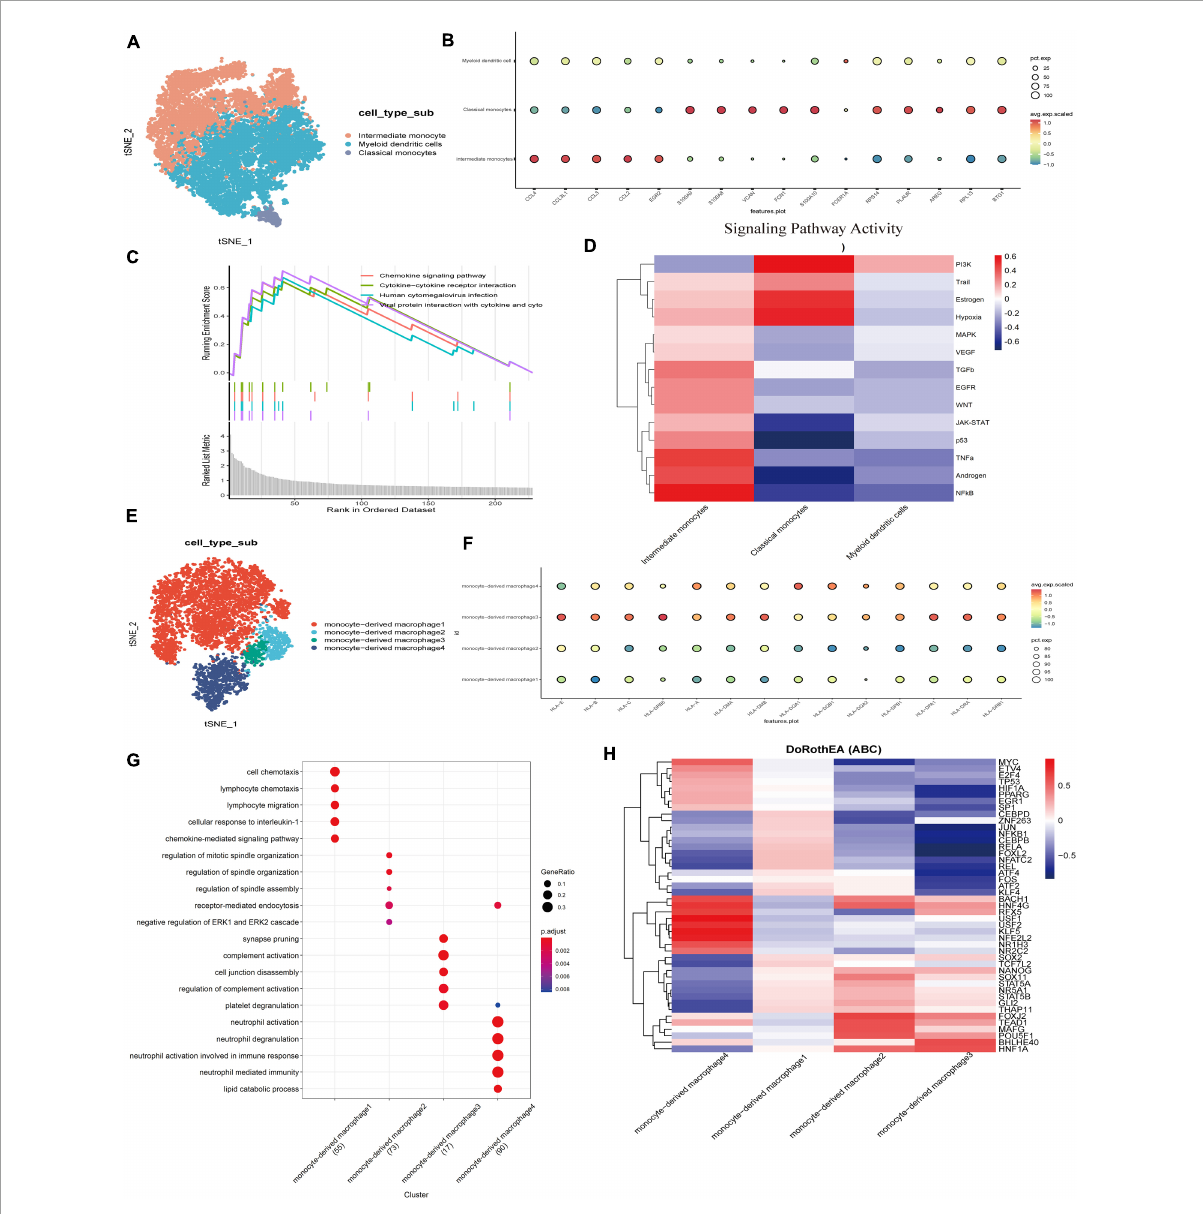
FIGURE3 Transcriptome analysis of myeloid cells led to the detection of predominantly monocytes and macrophages with pathways involved in immune metabolism and inflammation. (A) TSNE showing myeloid cell subsets. Different cell types are indicated by different colors. (B) Three major cell types in myeloid cells were identified and annotated based on the expression pattern of canonical cell markers. (C) Pathway display of the top four in the GSVA enrichment score of myeloid cells. (D) Heatmap of top 50 highly variable TF activities among the myeloid cell subsets; the z-scores of TF activities are coded. (E) The UMAP of a new subgroup of intermediate monocytes. (F) Dot plots showing HLA gene scores for different macrophage populations. (G) Dot plots showing gene GO term enrichment in different macrophage populations. (H) Heatmap of top 50 highly variable TF activities among the Macrophage cell subsets; the z-scores of TF activities are